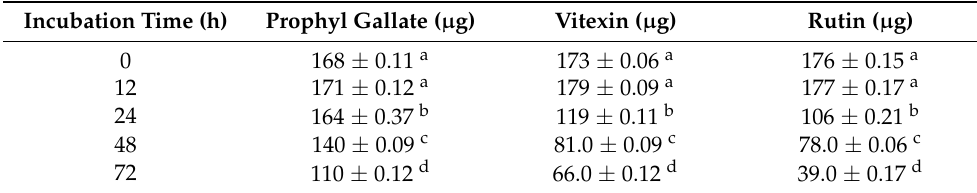
Table 4. Quantification of flavonol glycosides and ester derivatives in rumen fluids after different incubation periods by HPLC-DAD method.